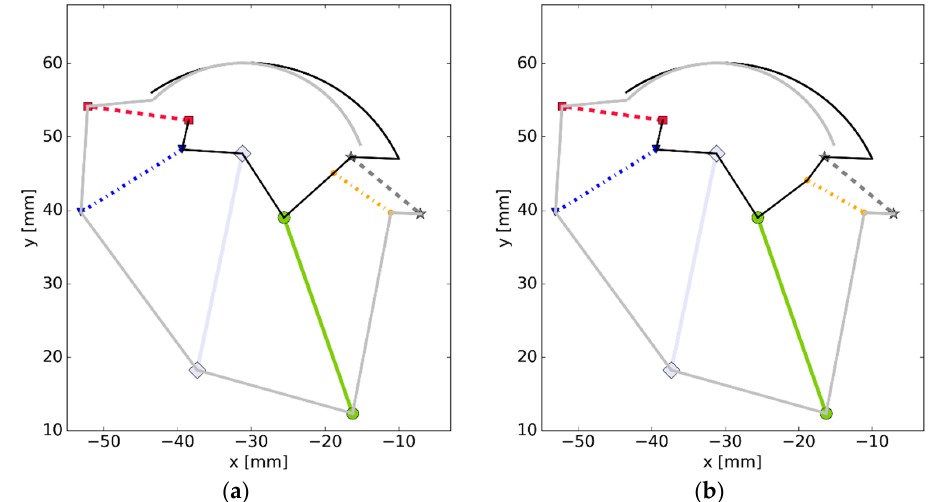
Figure 10. The model (as seen in the prepared software) ( a ) used in simulations #1 and #2; ( b ) with a modified PTT, where the grey (black) platform corresponds to TCS (TFS) and the colors of the links correspond to the ones used in previous